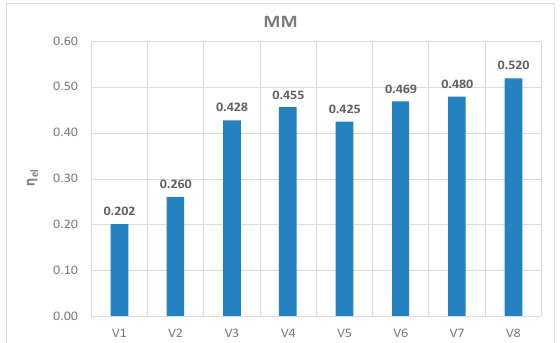
Figure 12. Maximum overall efficiency in particular variants of power plants (MM working fluid).